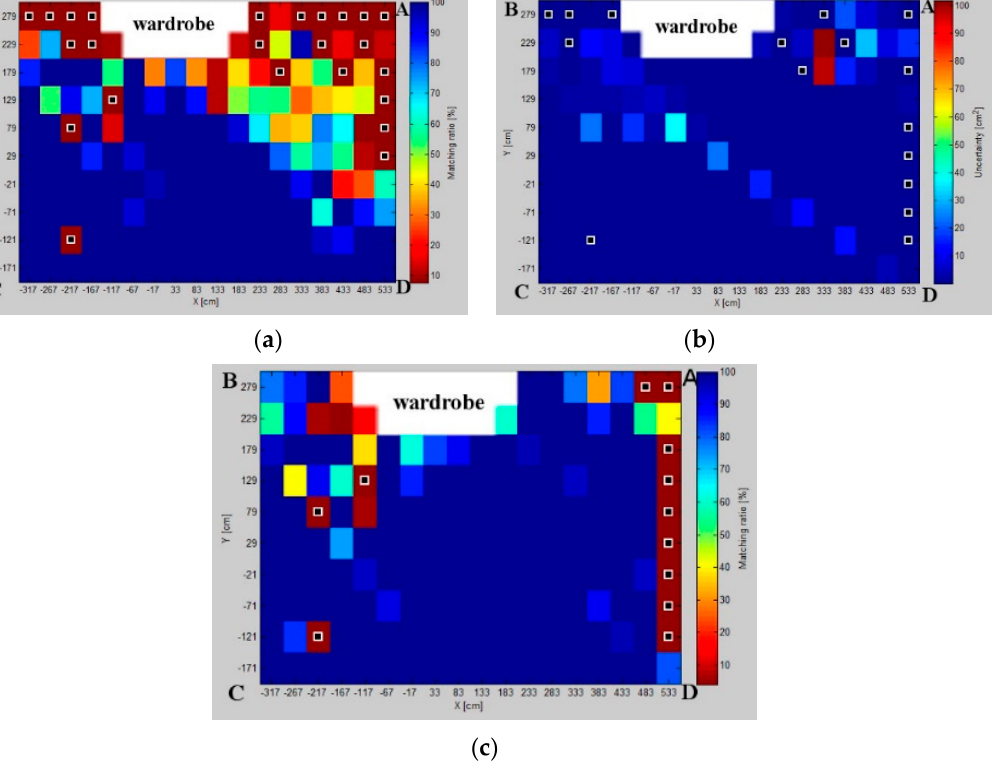
Figure 16. Validation of proposed model with physical experiment results for pairs: ( a ) AB ; ( b ) BD ; and ( c ) AD . Sampled positions with white frame markers show the sampling points with gross error.